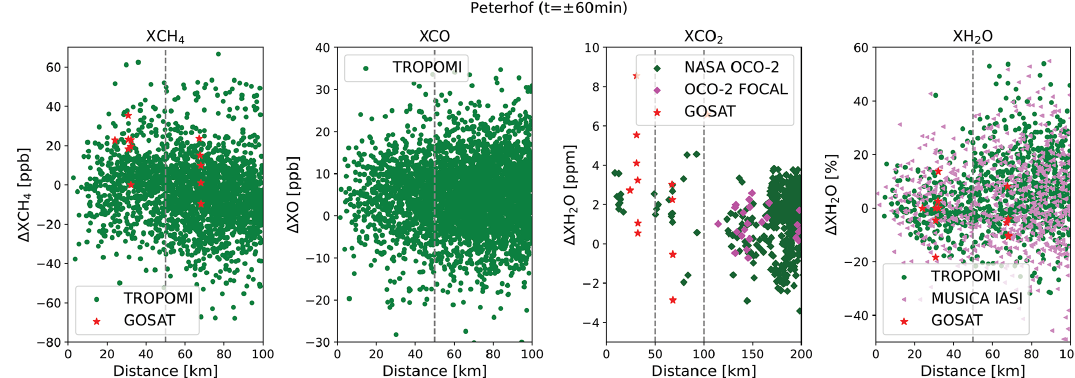
Figure A3. Difference between a single satellite measurement with the averaged COCCON measurement ( ± 1h of satellite overpass) with respect to their distance.